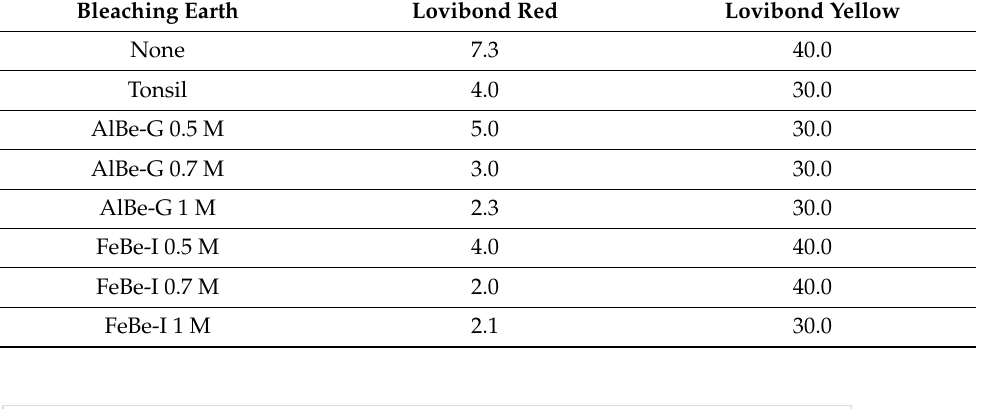
0.09 Table 5. Lovibond red and yellow of untreated and bleached oil samples (80 °C, t = 30 min, 250 rpm,